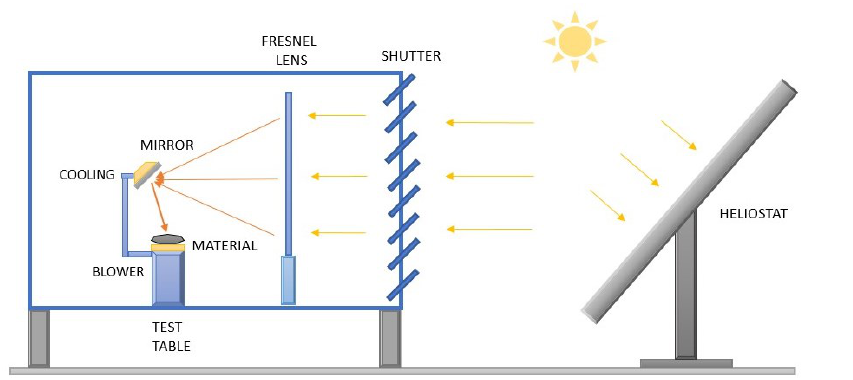
Figure 1. Simplified scheme of the new solar furnace at the PSA.